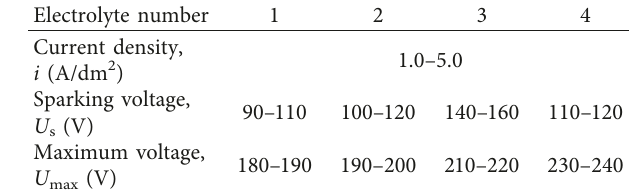
Table 2: PEO parameters. Electrolyte